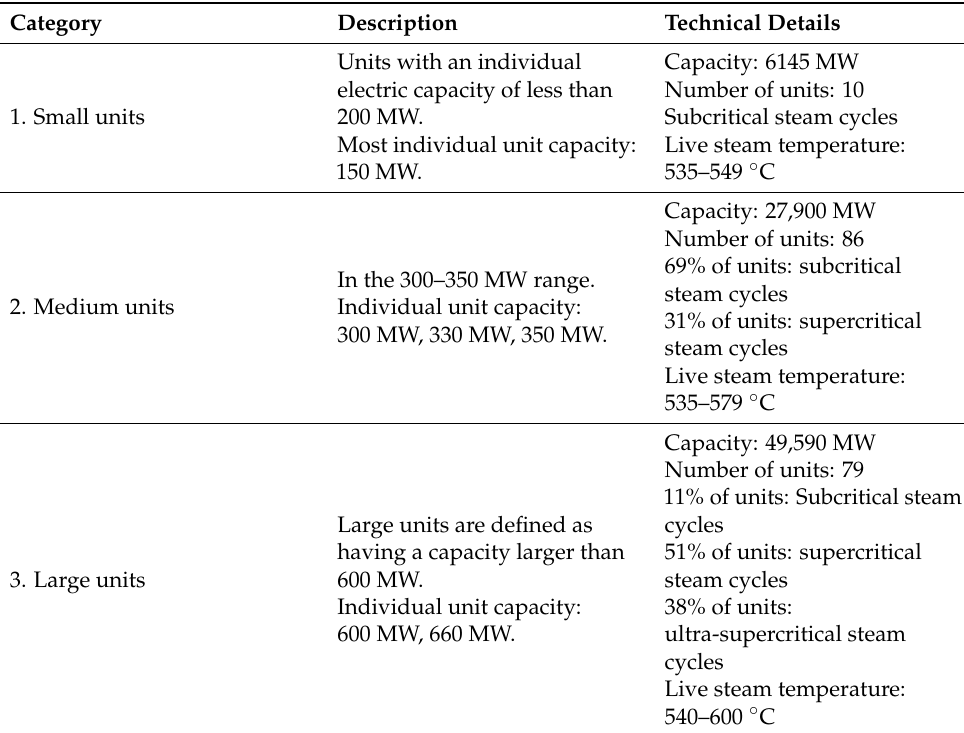
Table 3. Categorization of China Coal Power